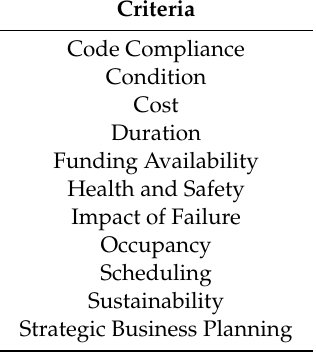
Table 6. The final list of building maintenance decision-making criteria in this